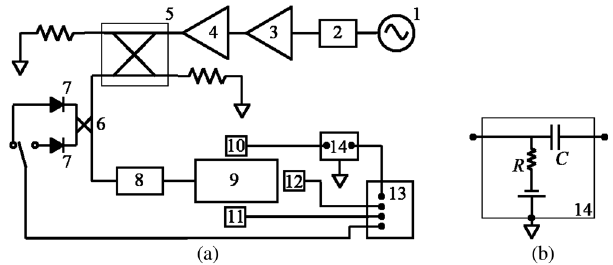
FIG. 1. MIT 17 GHz high power test stand schematic